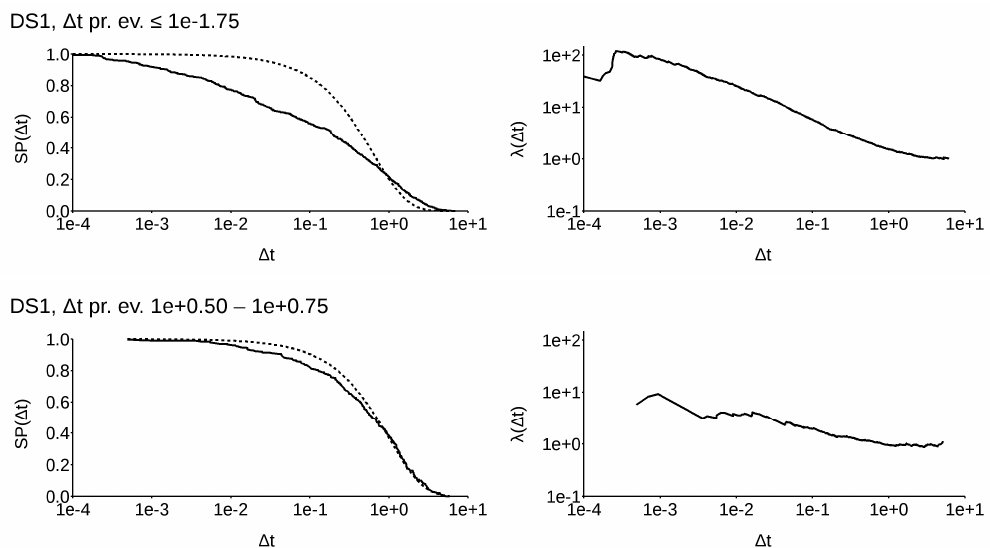
Figure 5. Survival probability ( left ) and λ ( ∆ t ) ( right ) for DS1 along the narrow bands, selected as in Figure 4. Solid lines refer to empirical functions, while dashed lines refer to Poissonian ones.